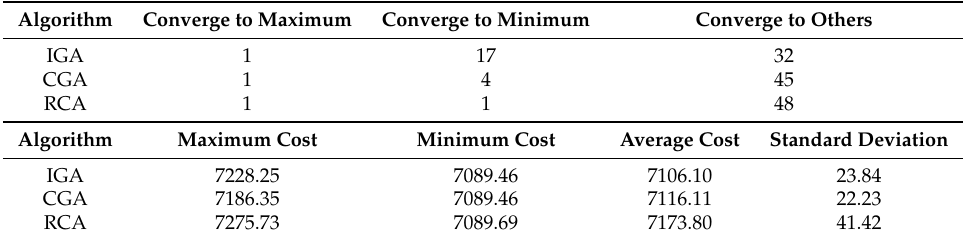
Figure 11. Standard deviation of total cost as a function of generations of IGA, CGA, and RCA. Table 6. Convergence summary and statistical indicators for 50 Monte Carlo simulations (MCS) of IGA, CGA, and RCA at iteration